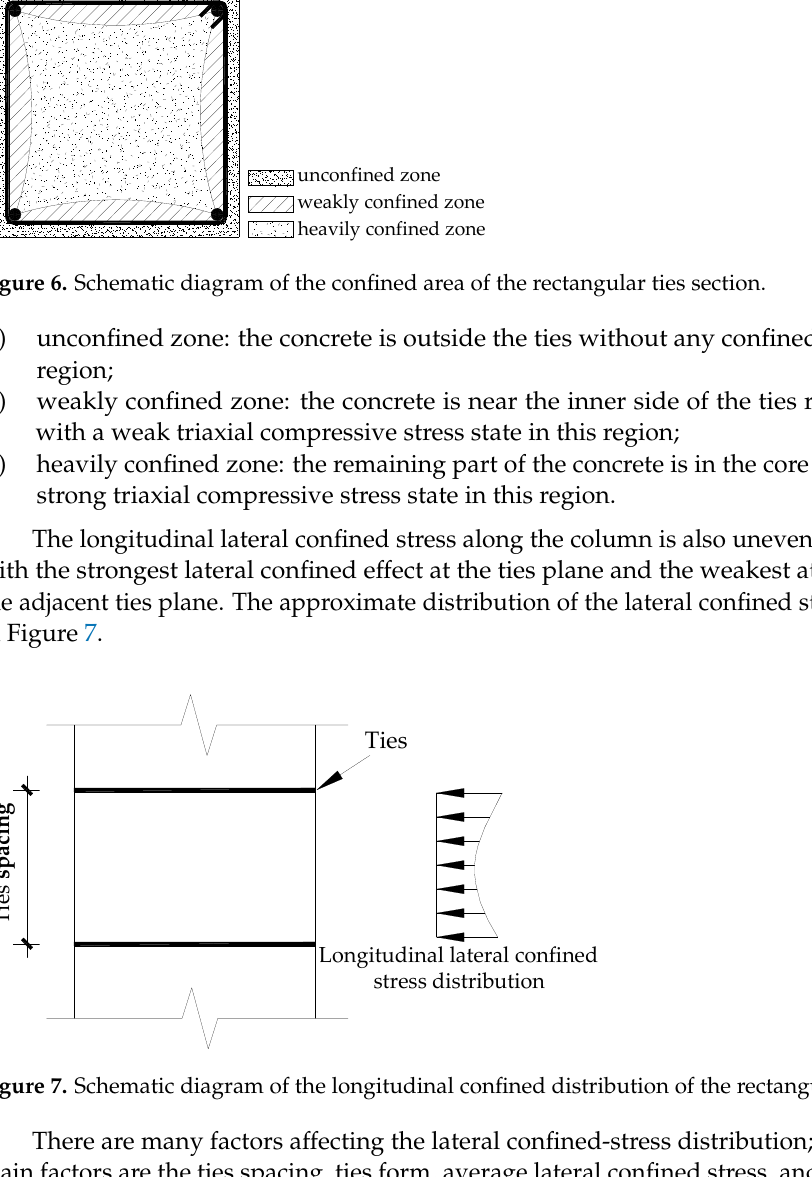
Figure 5. Passive con fi ned stress that develops in the sections: ( a ) Rectangular or square cross-sec- tion; ( b ) Circular cross-section.